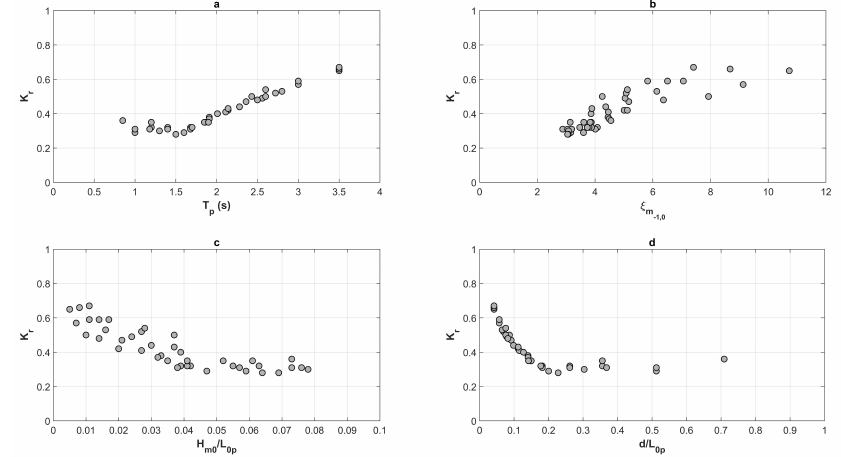
Figure 5. Reflection coefficient K r as a function of peak period T p ( a ), surf similarity parameter ξ m ( b ), offshore wave steepness H m